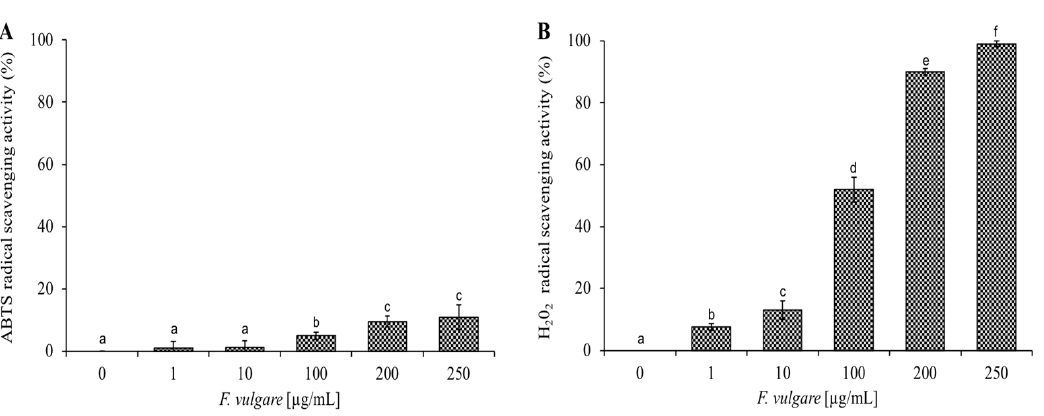
Figure 6. Determination of the antioxidant activity of F. vulgare subsp. vulgare var. vulgare EO. Panel ( A ) shows the abatement activity of ABTS radicals obtained after 10 min of incubation and reported as % of ABTS removed with respect to the control. Panel ( B ) shows the hydrogen peroxide scavenging activity, measured after 30 min of incubation, and reported as % of H 2 O 2 removed relative to the control. Data were presented as mean and standard error and they were analyzed with a paired t-test. Bars not accompanied by the same letter were significantly different at p < 0.05.